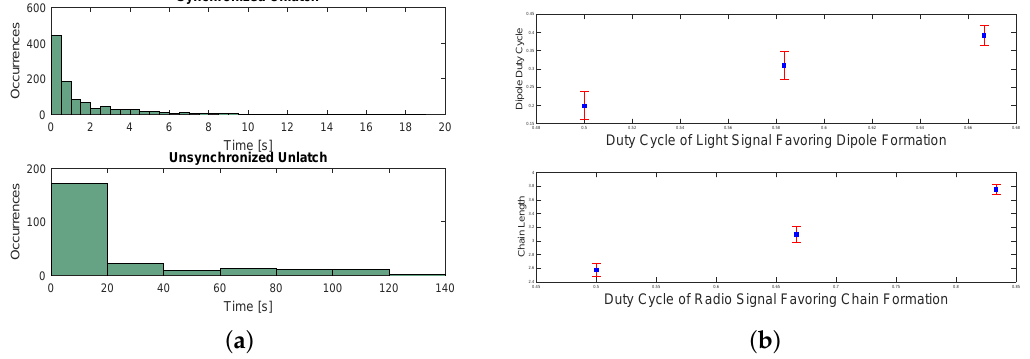
Figure 16. ( a ) Interaction time distribution: synchronized unlatching can be seen to allow for more efficient breaking of a bond; ( b ) dynamic behavior changes upon perceiving environmental